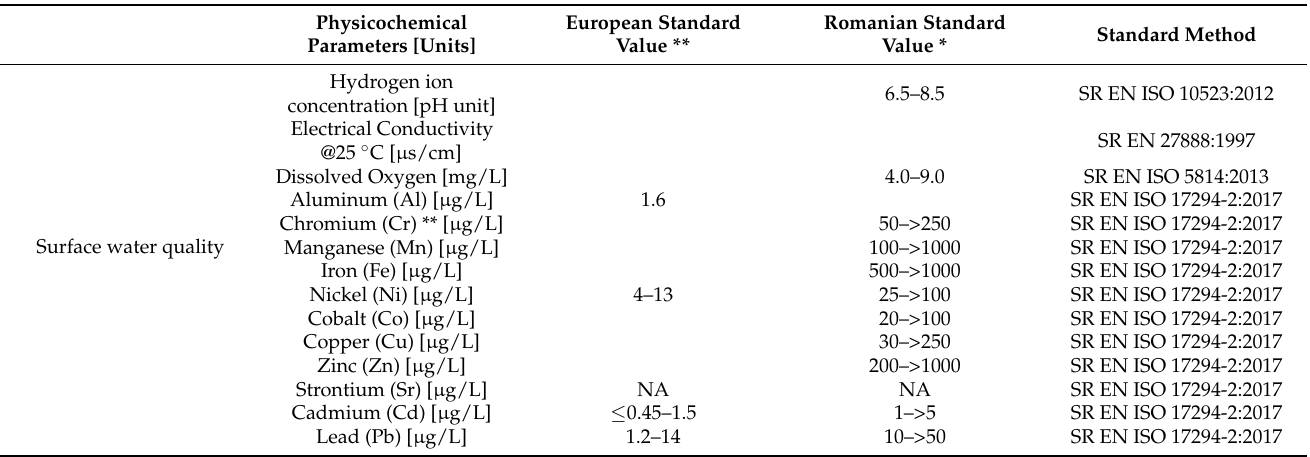
Table 3. Physicochemical parameters for surface water (including rivers and lakes) provided by both European and Romanian legislations, and standard